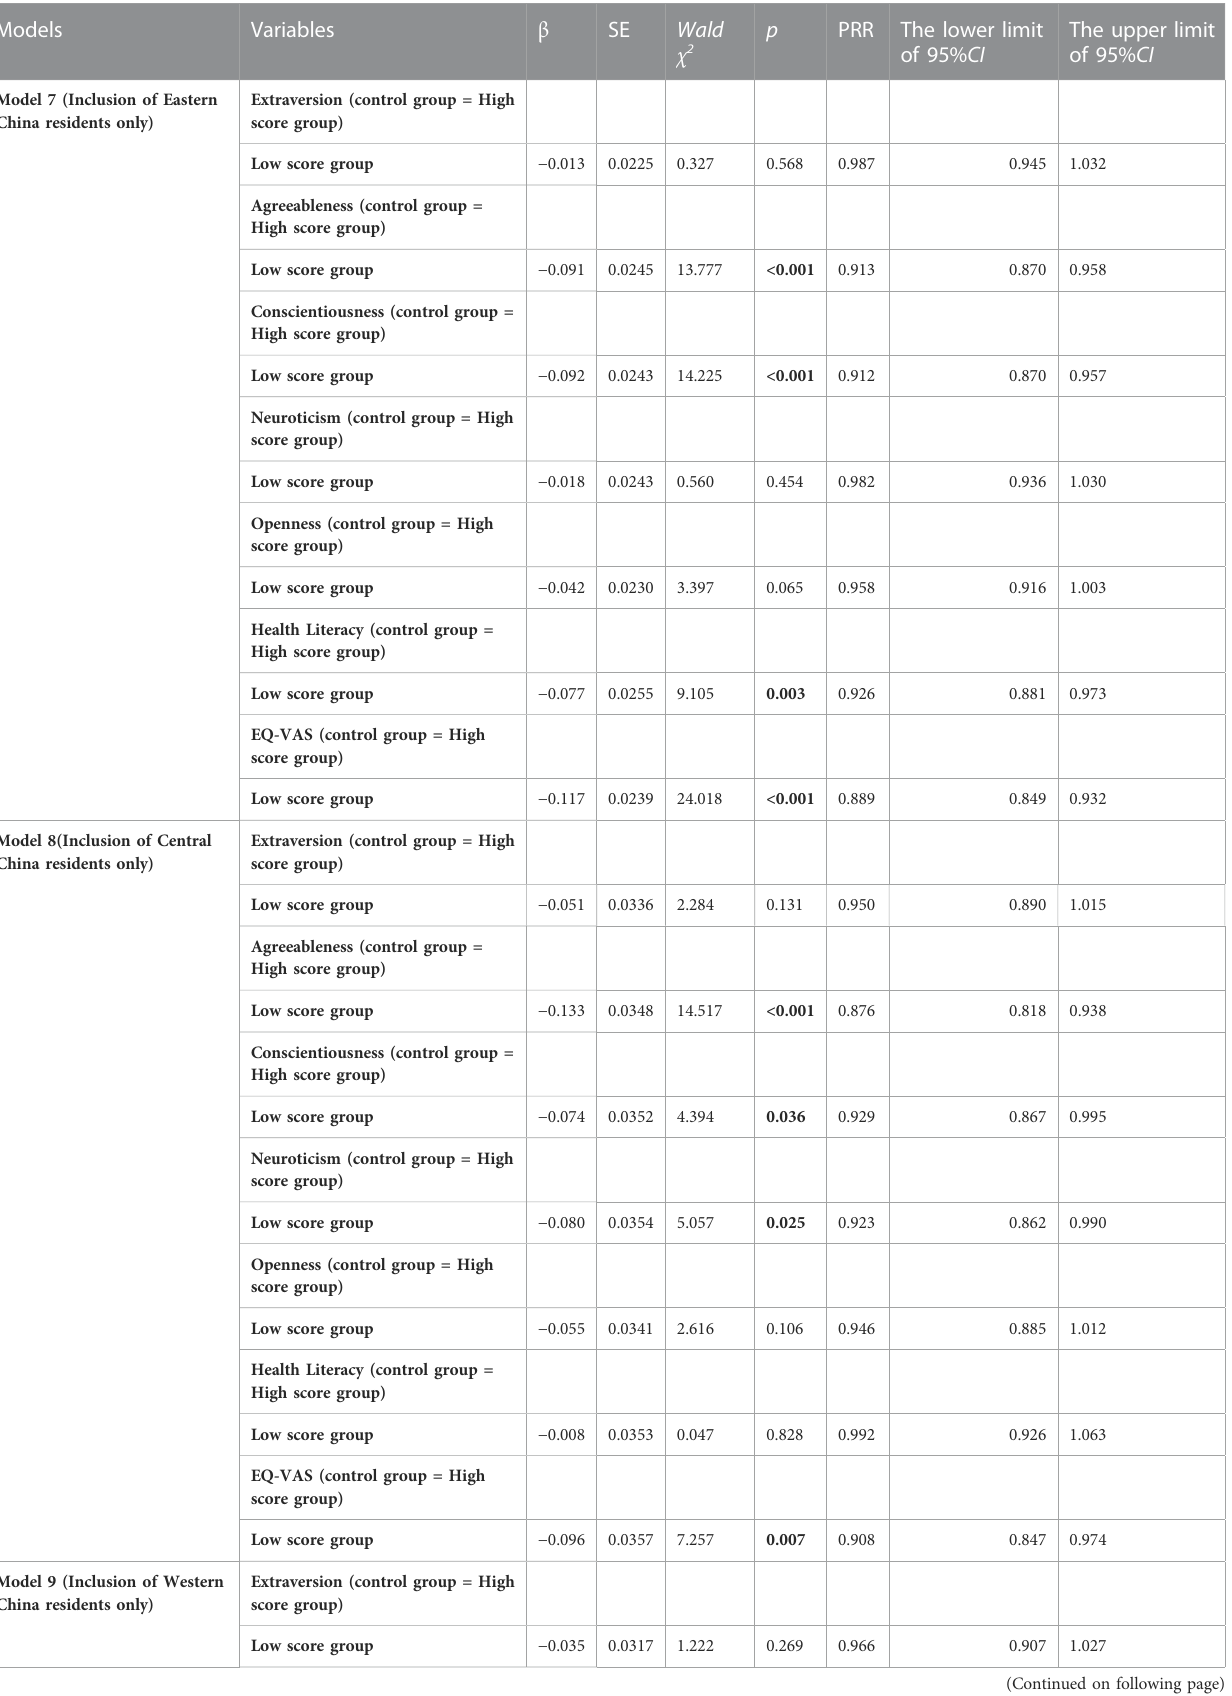
TABLE 5 Results of analysis of subgroups by region (dependent variable: likelihood of residents focusing on safety).